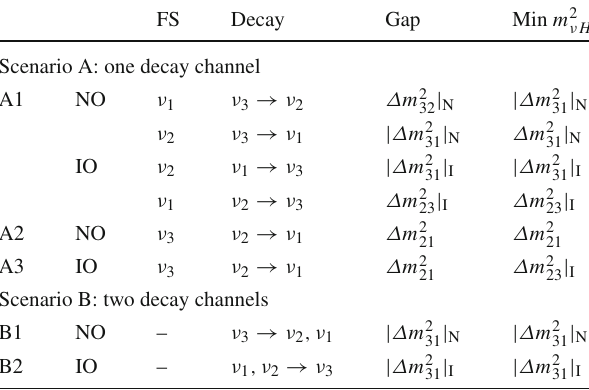
Fig. 1 CMB TT power spectra of ultra-relativistic invisible neutrino decay scenarios relative to the Planck 2018 best-fit (cid:7) CDM cosmology. In each case, we vary only the effective mass parameter X (Eq. (26)) and effective transport rate Y (Eq. (27)), while keeping all other cosmo- logical parameters fixed at their best-fit (cid:7) CDM values. Top : Variations between scenarios A (solid line) and B (dashed line) for a range of Y values, with X fixed at X = 298 or, equivalently, m ν H = 0 . 05 eV assuming T 0 = T ν, 0 . Bottom : Variations in scenario B with respect to the decaying neutrino mass m ν H , with T 0 = T ν, 0 and at a fixed the